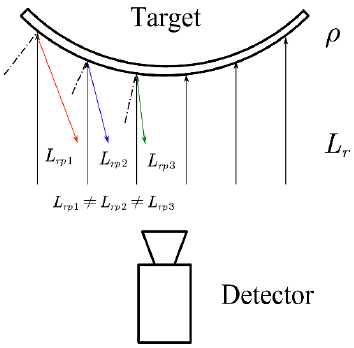
Figure 3. Radiances reflected by a curved surface are not equal.